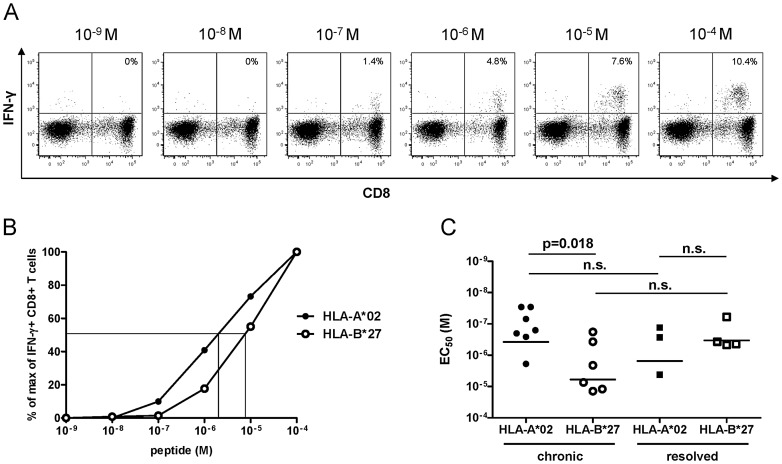
Functional avidity of HCV-specific CD8+ T cells.(A) Representative flow cytometry plots showing intracellular IFN-γ staining of a CTL line exposed to target cells pulsed with a range of peptide concentrations. PBMCs from a subject chronically infected with HCV were stimulated for two weeks with the HLA-A*02-restricted NS31073 epitope. Prior to intracellular IFN-γ staining, the CTL line was cocultured for 5 hours with HLA-A*02+ EBV-immortalized B-cell lines (B-LCLs) pulsed with serially diluted concentrations of the cognate peptide. The background value from the negative control (B-LCLs without peptide loading) was subtracted from all measured response frequencies (IFN-γ+ CD8+/total CD8+). (B) Representative data from intracellular IFN-γ staining of a CTL line specific for the HLA-A*02-restricted NS31073 epitope (filled circles) and a CTL line specific for the HLA-B*27-restricted NS5B2841 epitope (open circles) across a range of peptide concentrations. The background value from the negative control (B-LCLs without peptide loading) was subtracted from all measured response frequencies (IFN-γ+ CD8+/total CD8+), which were then normalized to the maximum response by defining the smallest value as 0% and the largest value as 100%. (C) The functional avidity of CTL lines, derived from chronically HCV infected subjects, specific for HLA-A*02-restricted epitopes (n = 7, filled circles) and the immunodominant HLA-B*27-restricted epitope NS5B2841 (n = 6, open circles), as well as of CTL lines derived from subjects with resolved infection specific for HLA-A*02-restricted epitopes (n = 3, filled squares) and the immunodominant HLA-B*27-restricted epitope NS5B2841 (n = 4, open squares). Functional avidity was determined as the concentration of peptide required to achieve half-maximal IFN-γ induction (EC50). P-values were calculated using the Mann-Whitney U-test. Horizontal bars represent mean values.